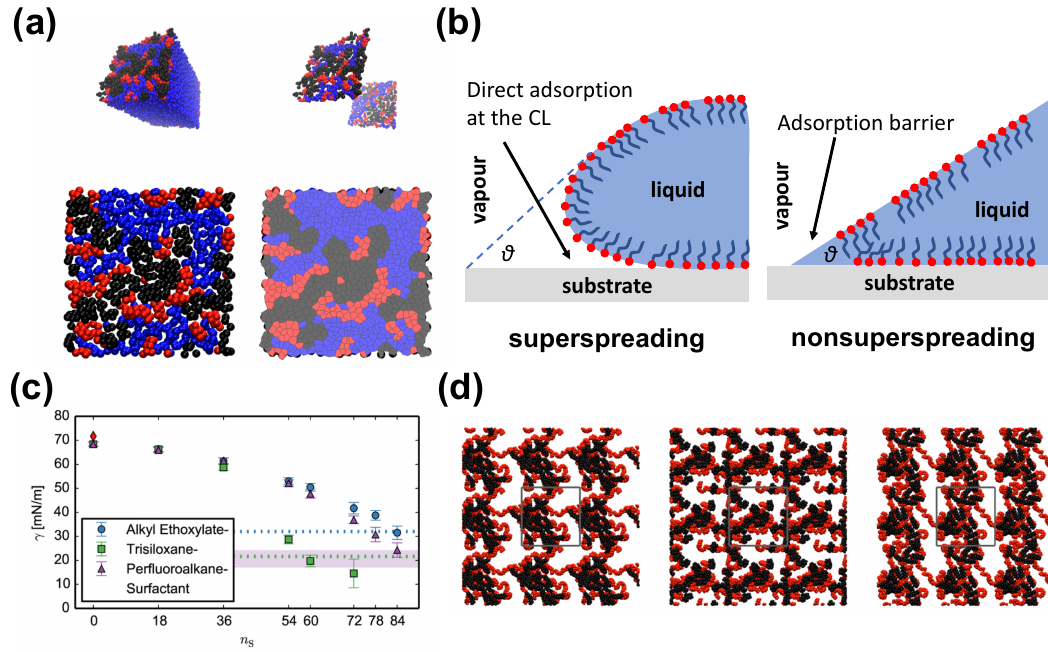
Figure 5. Results from all-atom simulation. ( a ) Covered surface area by surfactant and related analysis based on advanced algorithms and Voronoi tessellation. Reprinted with permission from Ref. [21]. Copyright 2014 American Chemical Society; ( b ) Superspreading versus nonsuperspreading: Conformation of the droplet at the CL as suggested in Ref. [22]. ( c ) Surface tension obtained by experiment and simulation for different surfactants as indicated. Reprinted with permission from Ref. [21]. Copyright 2014 American Chemical Society; ( d ) Top view of the LV interface containing 18 surfactant molecules. From left to right: alkyl ethoxylate, trisiloxane, and perfluoroalkane surfactants. The hydrophilic part of the surfactants is in red, while the hydrophobic is in black. Water is omitted for the sake of clarity. Reprinted with permission from Ref. [21]. Copyright 2014 American Chemical